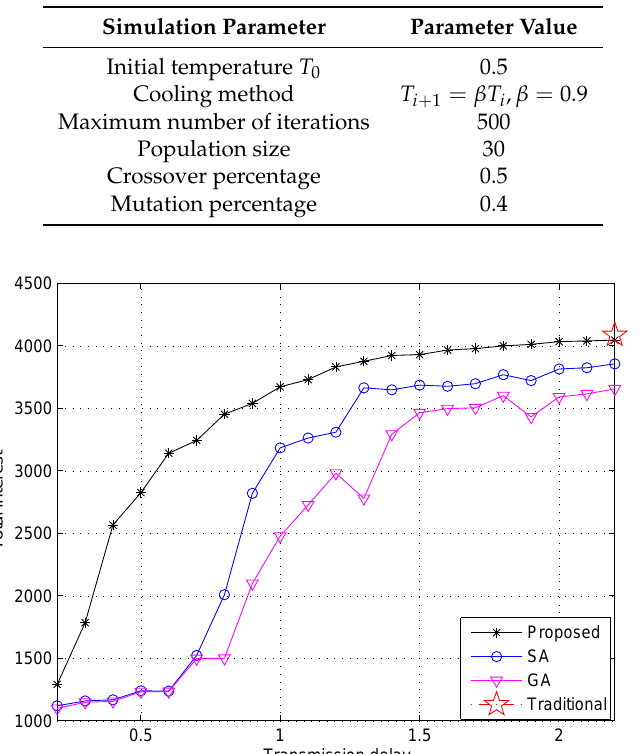
Table 2. Simulation settings for simulated annealing (SA) and genetic algorithm (GA).